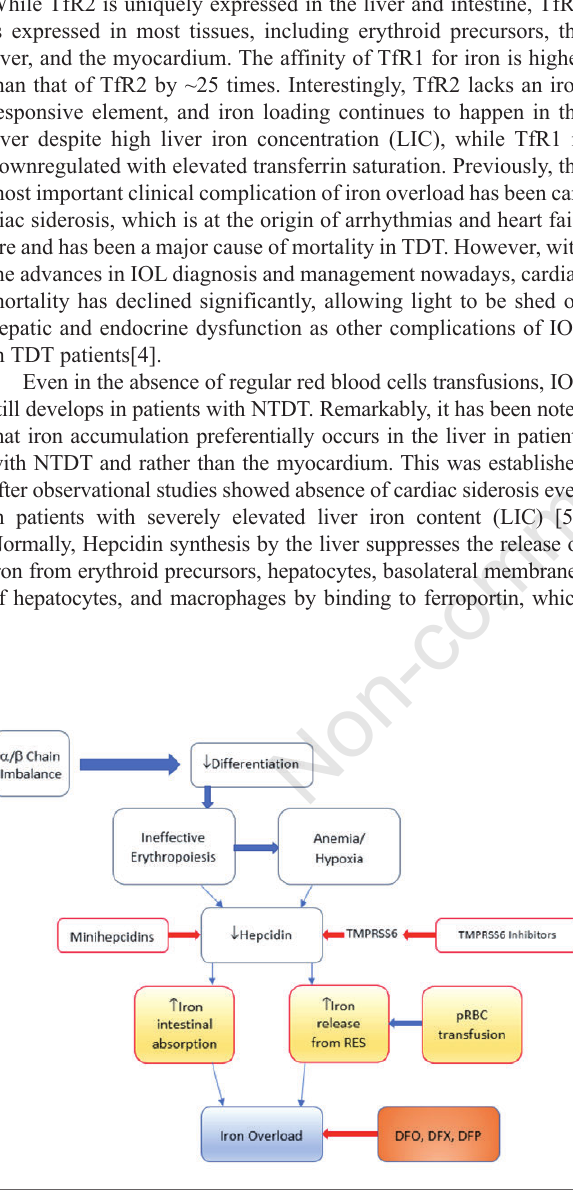
Figure 1. Pathophysiology, mechanism of IOL and novel thera- pies targeting IOL in β -Thalassemia. TMPRSS6, transmembrane protease serine 6; DFO, deferoxamine; DFP, deferiprone; DFX,